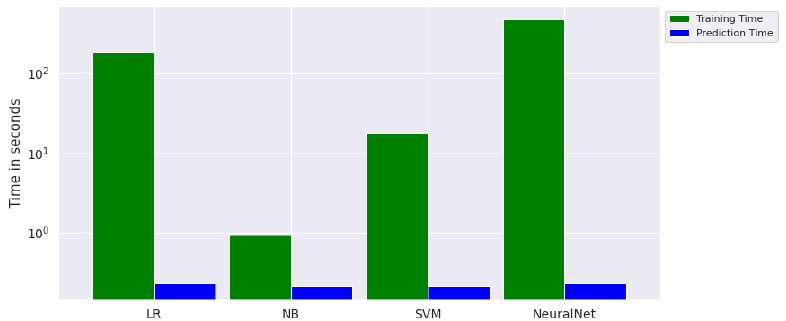
Figure 6. Comparing Performance of Topic classifiers in terms of Training and Prediction time.